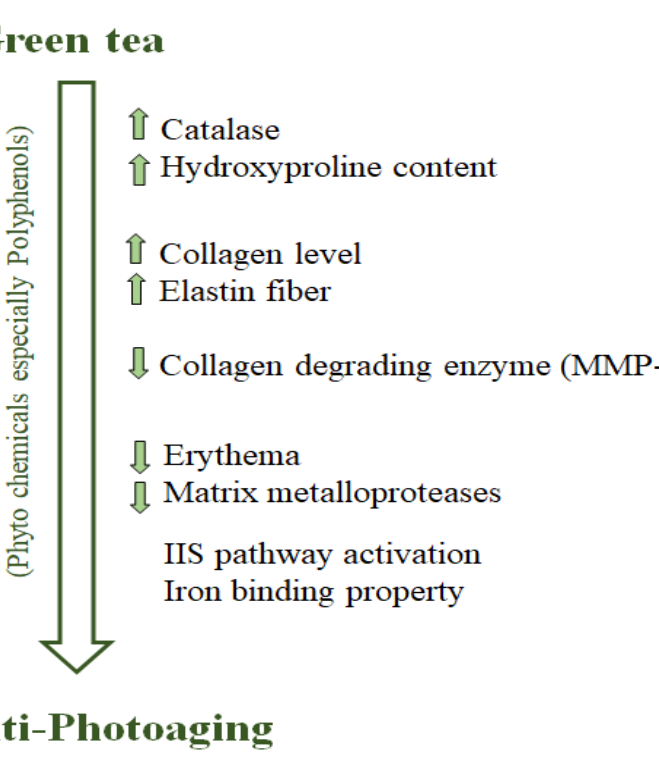
Figure 1. Antiphotoaging property of green tea phytochemicals. Polyphenols present in green tea positively alter the physiochemical features of the system, and confer protection from accelerated photoaging[55,56,83,84,88,93,97–101].